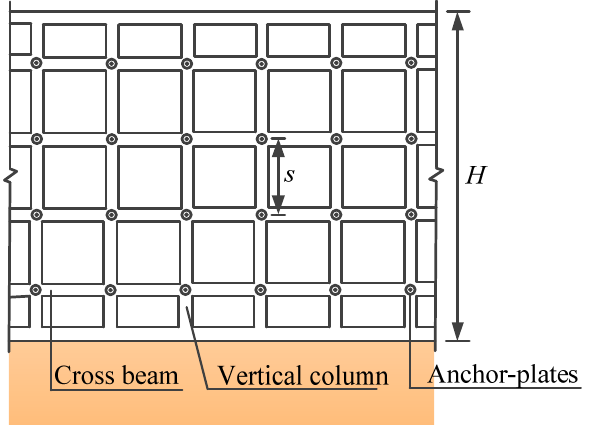
Figure 3. Elevation view of a frame with a prestressed anchor-plate supporting structure.